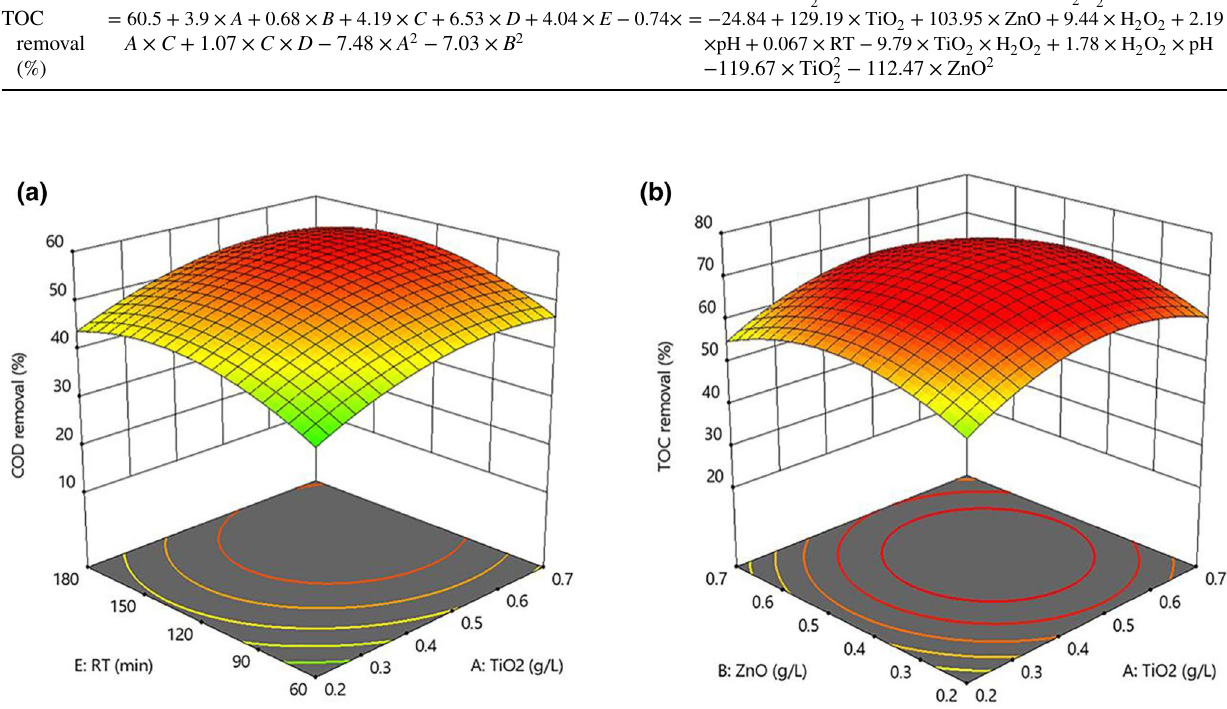
conditions from Table 6: TiO 2 dosage = 0.535 g/L, ZnO